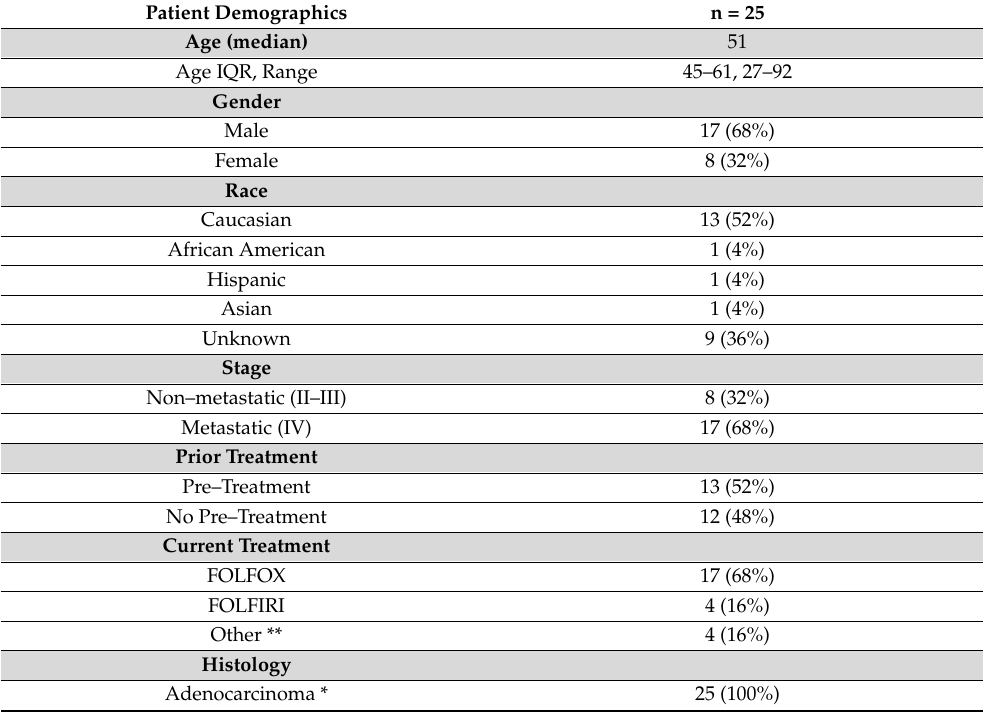
Table 1. Clinical demographic for